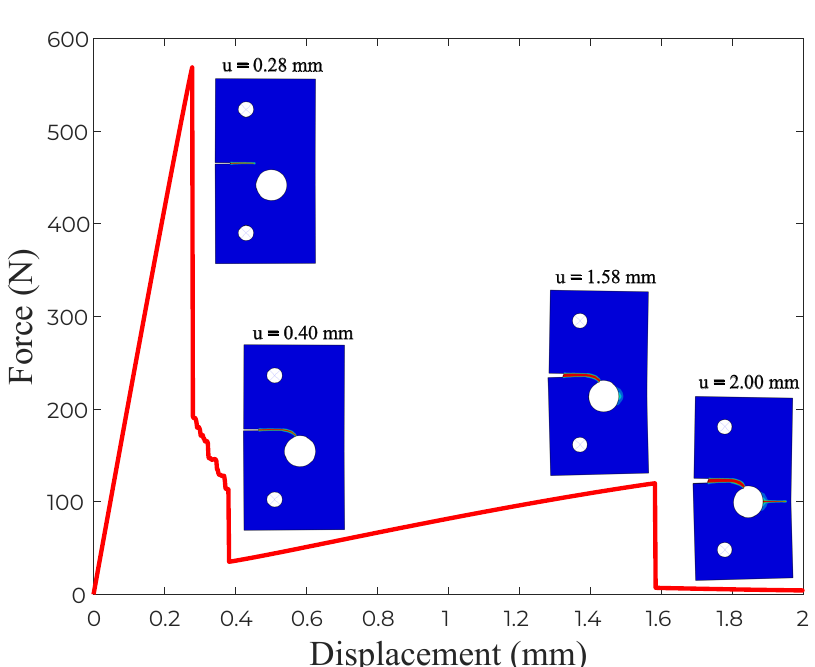
Figure 7. Notched plate with an eccentric hole: force versus displacement curve, with several snapshots of several cracking events superimposed.